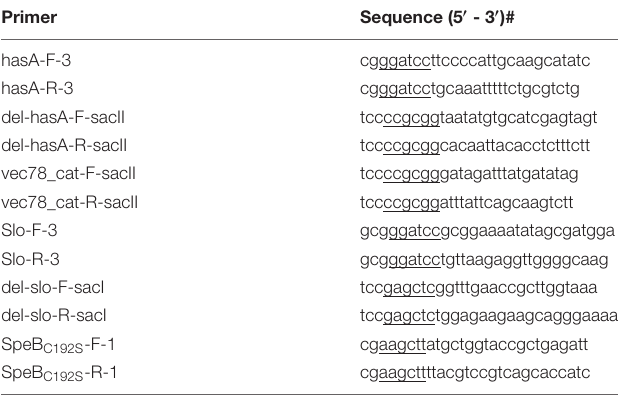
TABLE 2 | Primers used in this